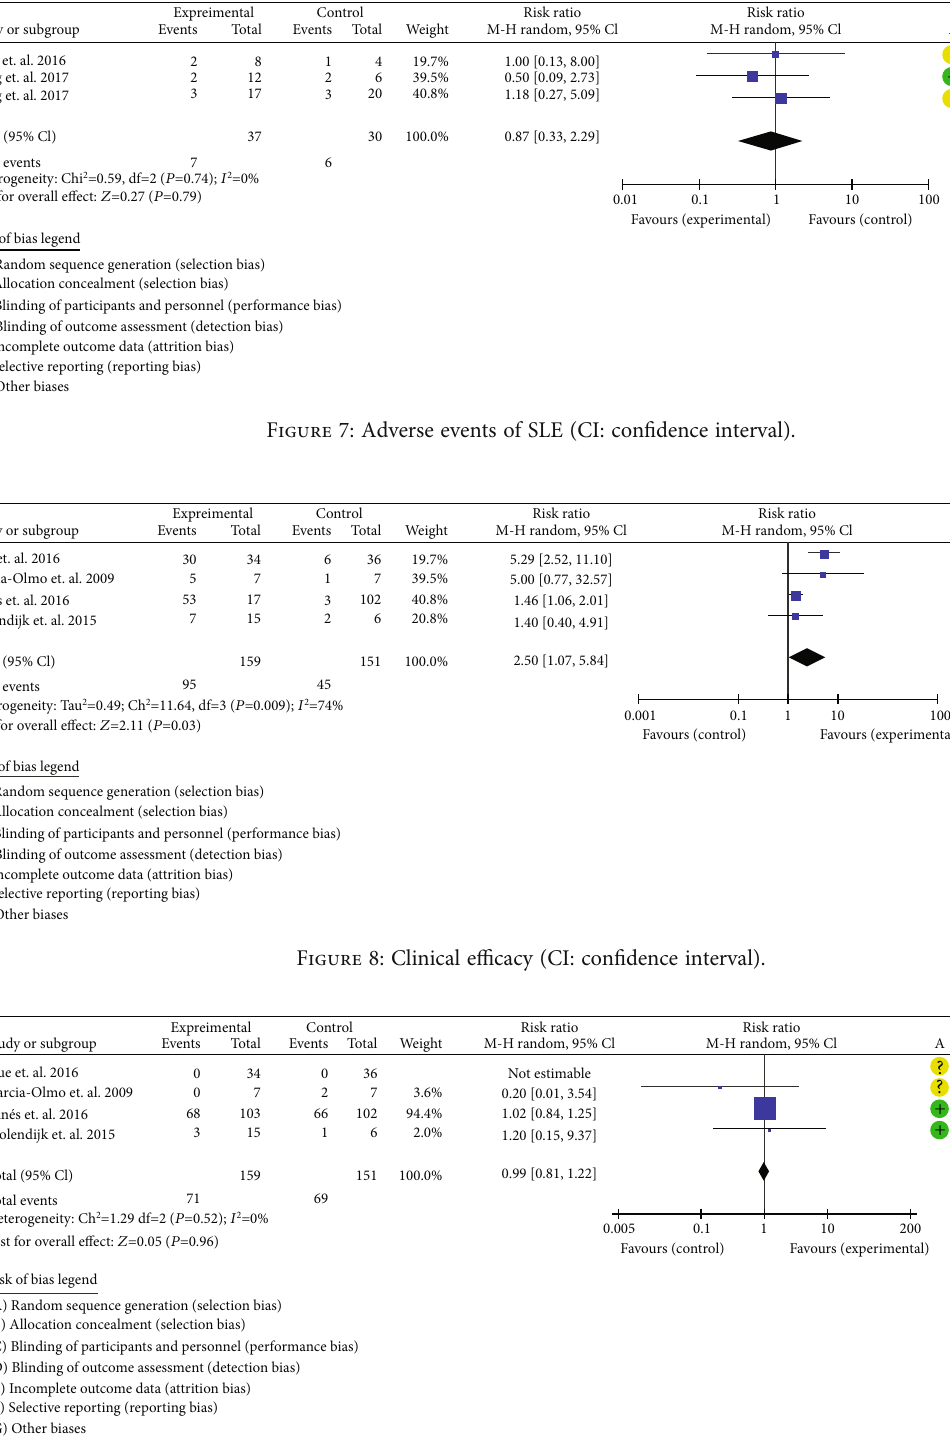
Figure 9: Adverse events of in fl ammatory bowel disease (CI: con fi dence